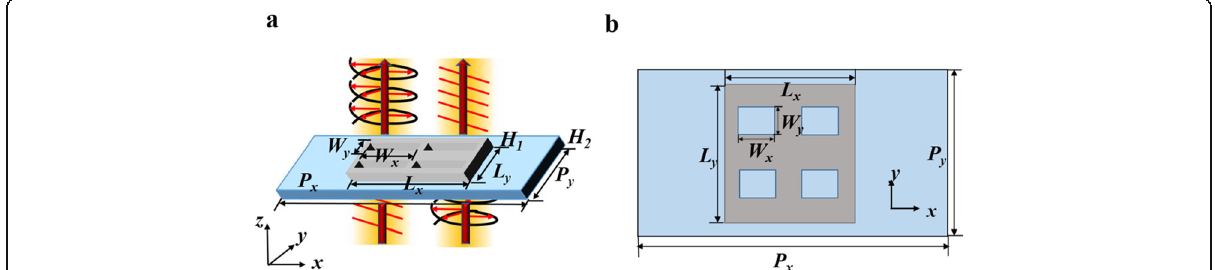
Fig. 1 Schematics of the quarter waveplate. The lights are normally incident from the bottom. a 3D view of the quarter waveplate. b Top view of a unit